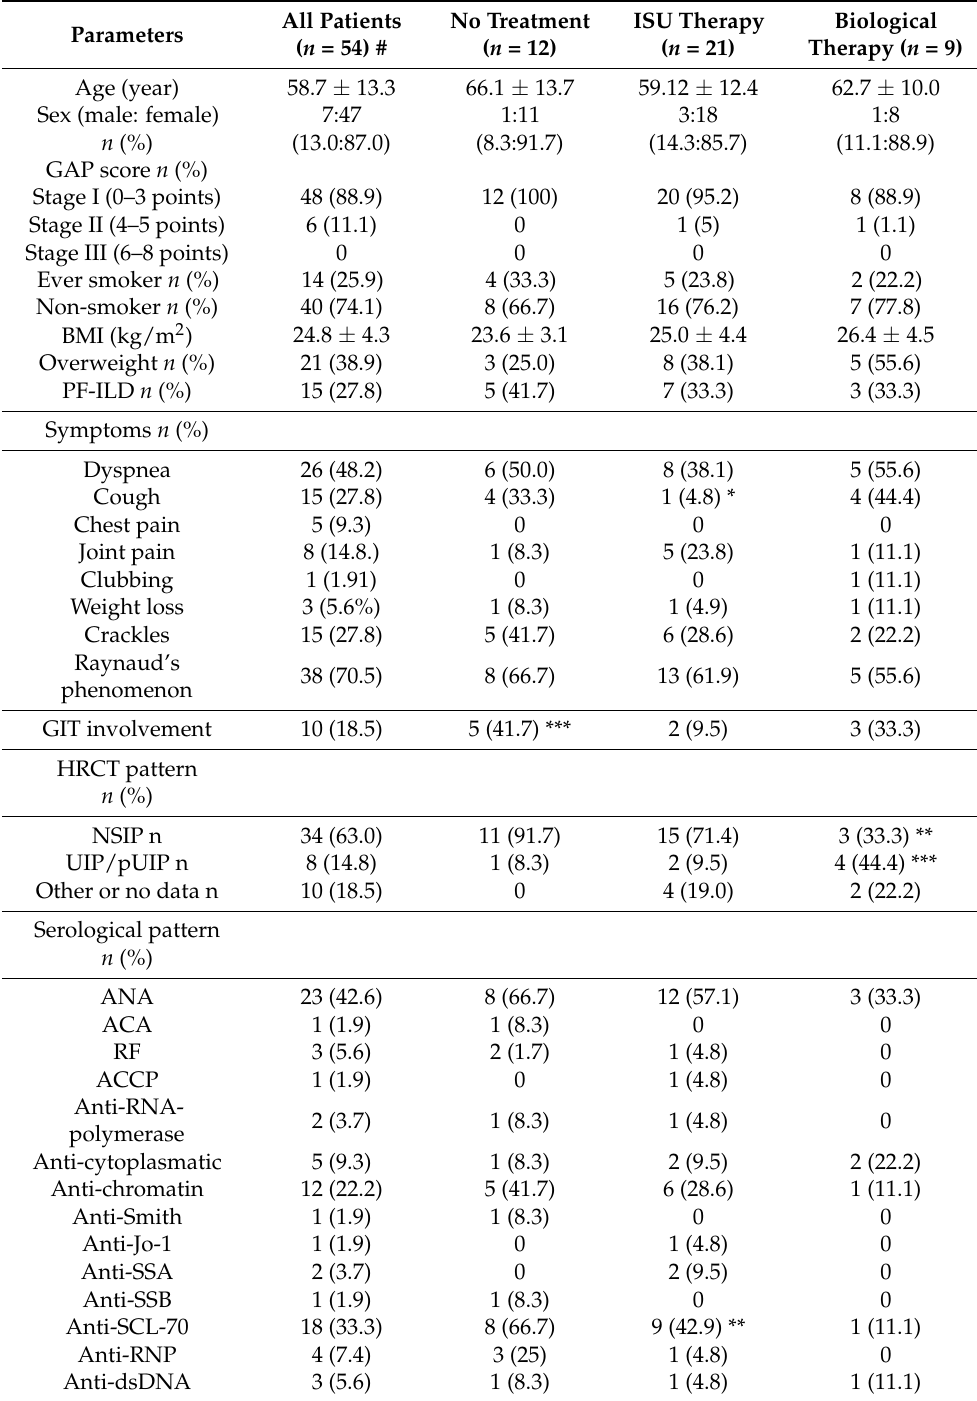
Table 1. Patient